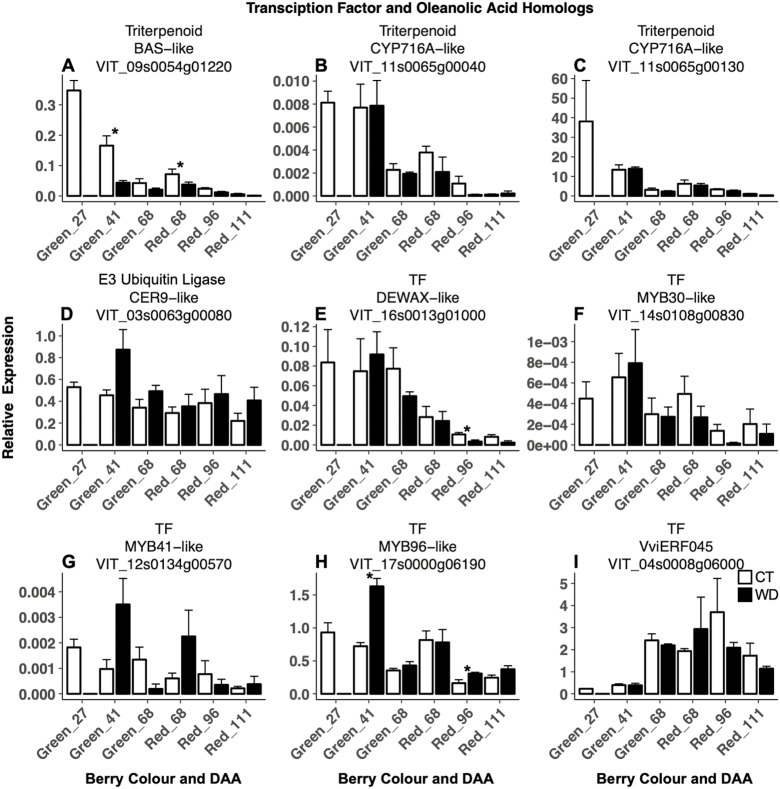
Expression of candidate genes involved in the oleanolic acid biosynthesis, and transcription factors (TFs) and an E3 ubiquitin ligase involved in regulating cuticular wax development of berry skins of grapevines (Vitis vinifera L.) exposed to two irrigation treatments: well-irrigated (control, CT) and deficit irrigated (water deficit, WD). Error bars represent ±SE, and significant differences between treatments were determined by two-sample t-test (*P<0.05).